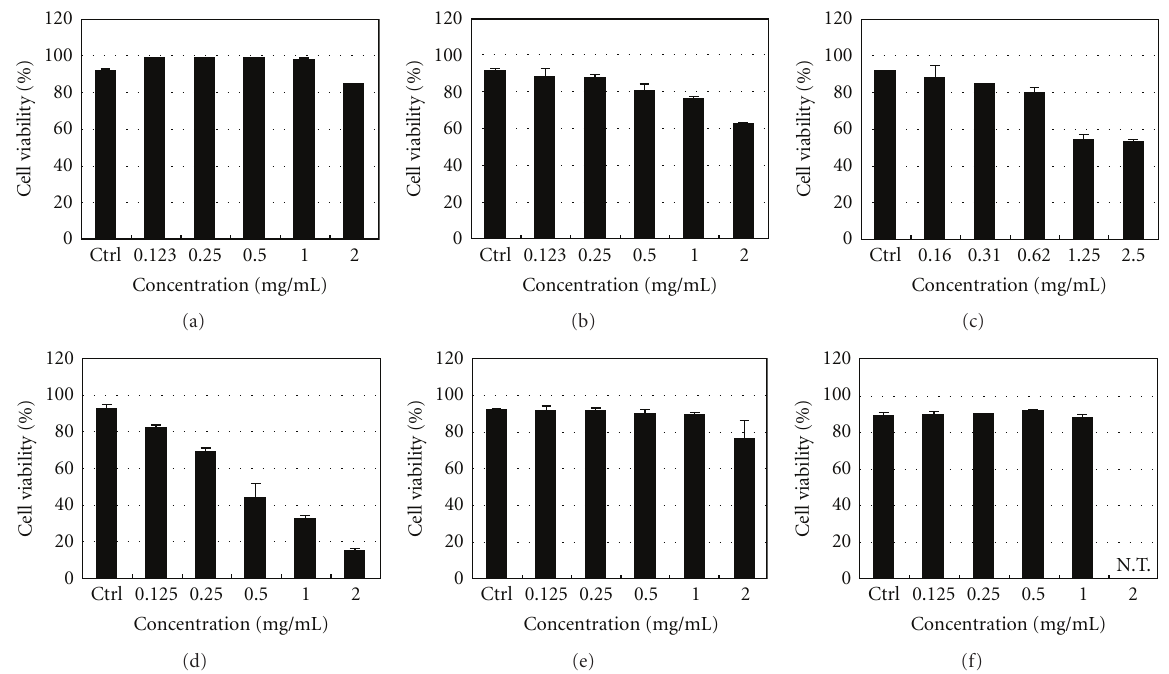
Figure 2: E ff ects of biodegradable polymers on cell viability by concentration. THP-1 cells were incubated with dissolved biodegradable polymers for 24 hours. Using flow cytometry with PI (0.625 μ g/mL), only living cells were counted in total cells. (a) P1, (b) P2, (c) P3, (d) P4, (e) P5, and (f) P6, N.T.: not tested.